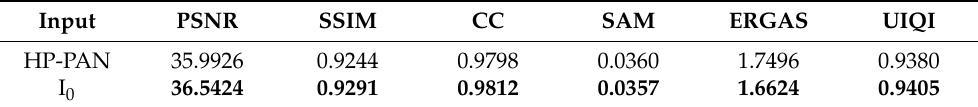
Table 5. Ablation study of the input for the feature extraction branch on the QB dataset. The best performance is shown in